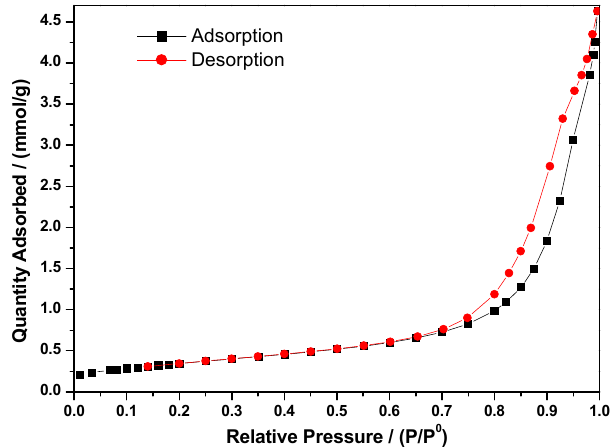
Figure 4. Adsorption and desorption curves obtained from the BET measurements of the β -CoMoO 4 nanoparticles.